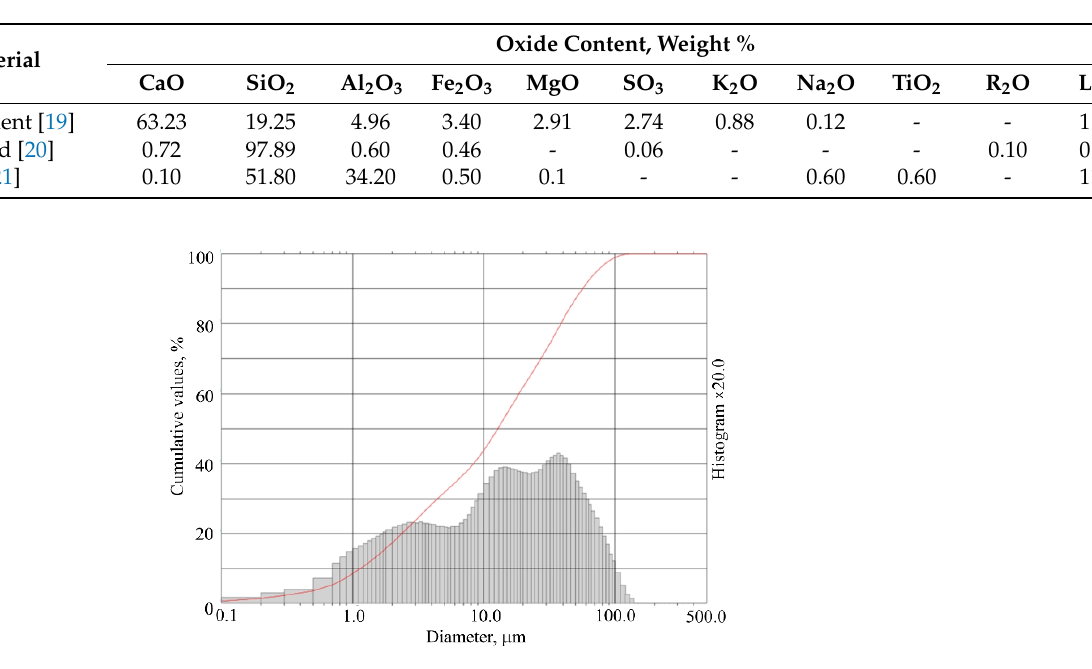
Figure 1. Distribution of Portland cement particles by size.